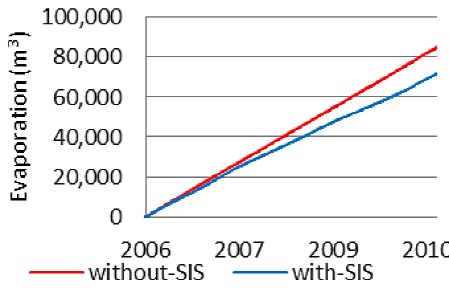
Fig. 9. Water flux from the river to the floodplain aquifer for the defined scenarios (light blue pattern refers to the period that the pumps were in operation).